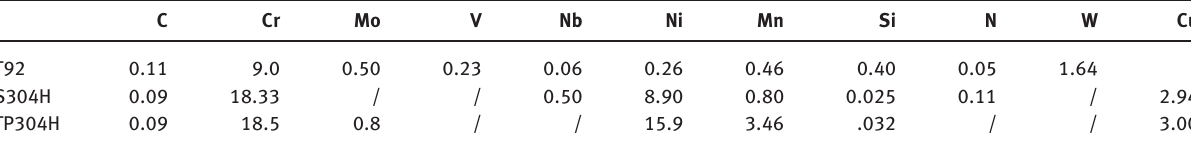
Table 1: Chemical compositions of investigated materials (wt%).